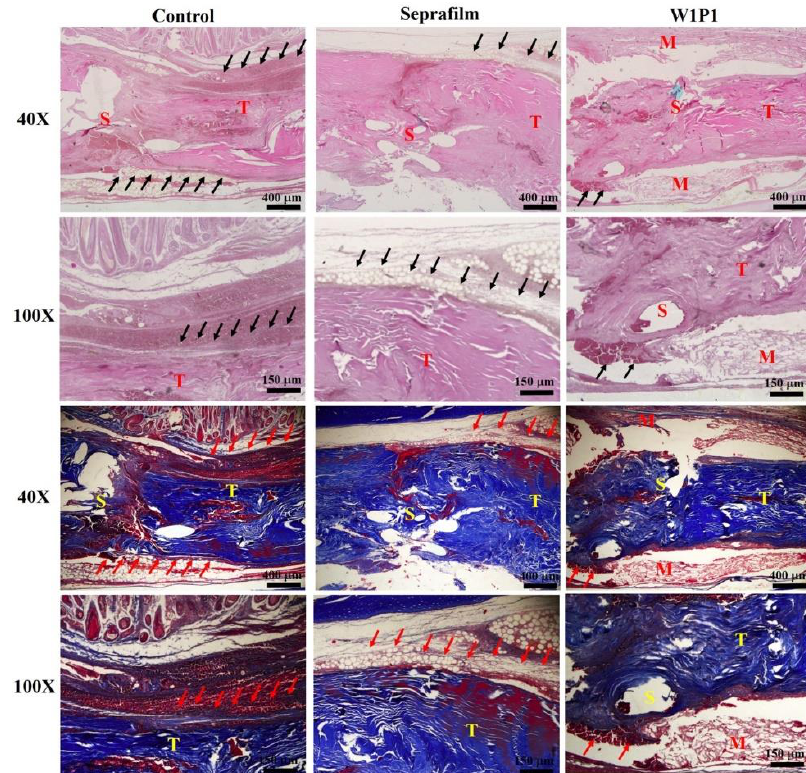
Figure 7. Histological sections stained with hematoxylin and eosin (H&E) (upper two rows) and Masson trichrome blue (lower two rows) of tendons receiving different treatments (S, surgical repair site; T, tendon; and M, material): The black (red) arrows indicate the scar tissue in H&E (Masson trichrome blue) stains. The control group exhibited the most scar tissue around the tendon, whereas the W1P1 group exhibited the least. The NFM can be seen in the W1P1 image, indicating that the material lasted more than 3 weeks. In the Seprafilm group, no remnants of the material were found through histological